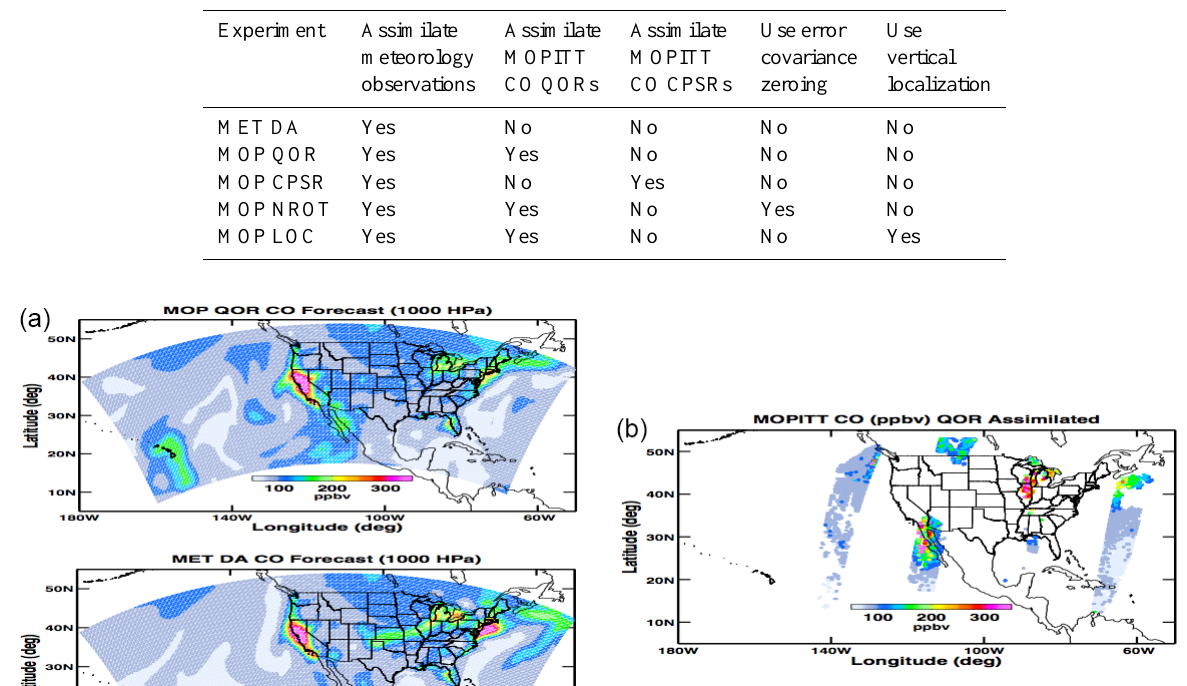
Table 1. Summary of the WRF-Chem/DART Forecast/Data Assimilation Experiments.